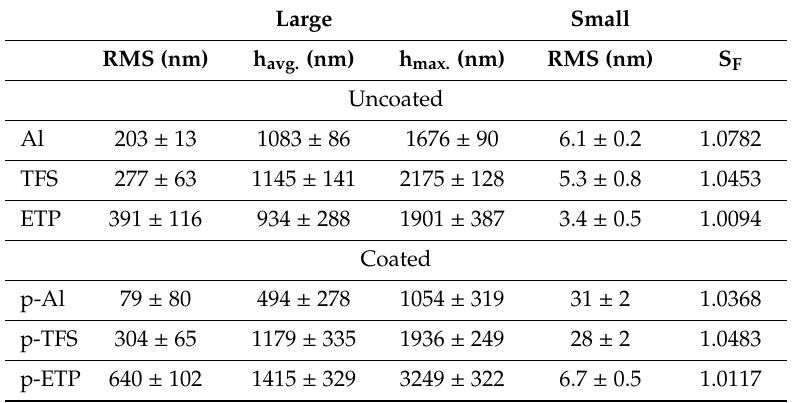
Figure 1. ( top ) 130 × 130 µ m 2 AFM topographic images of bare and ( bottom ) polyaleuritate-coated Al, TFS and ETP supports. Line profiles ( centre ) show the surface roughness modifications upon coating. Different coating patterns are proposed for Al, TFS and ETP, respectively. Table 1. Large and small scale roughness obtained from AFM for bare and polyaleuritate-coated Al, TFS and ETP. The S F parameter is the ratio between the topographic and the X-Y scanned areas; it is related to the specific surface area.